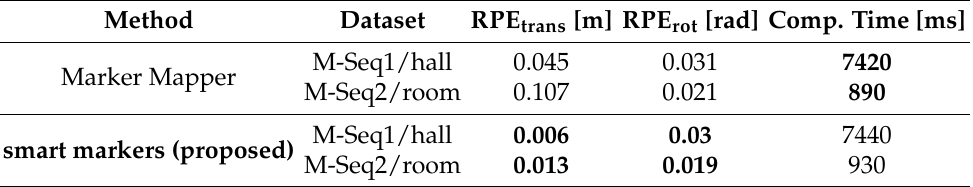
Table 3. Accuracy of the generated map of markers. RPE (RMSE) computed from translational and rotational pose parts, and processing times for datasets M-Seq1/hall and M-Seq2/room